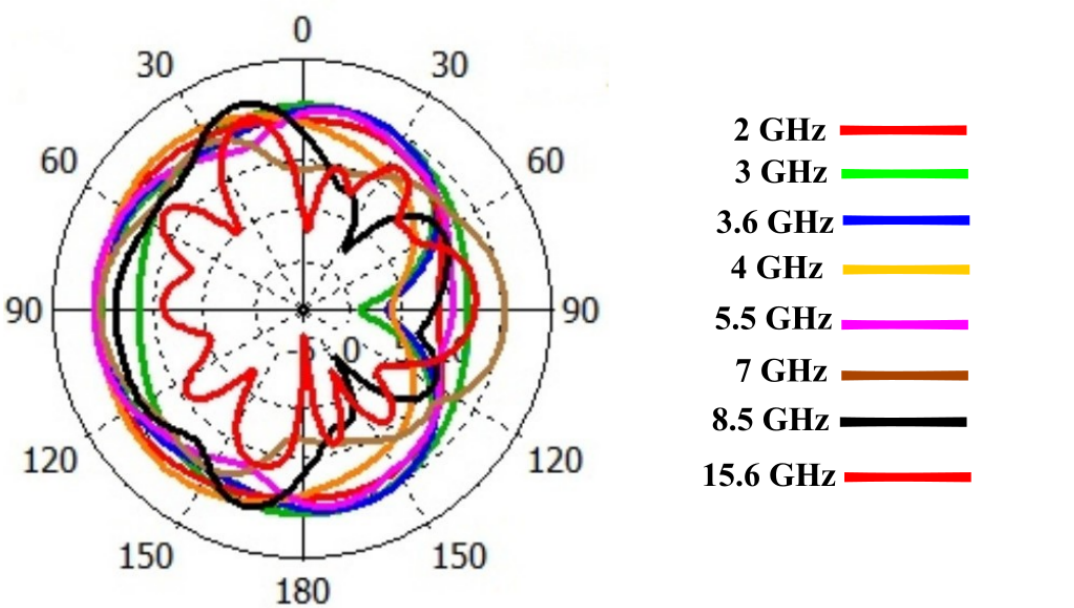
Figure 7. Power Pattern (YZ-plane) without the λ /20